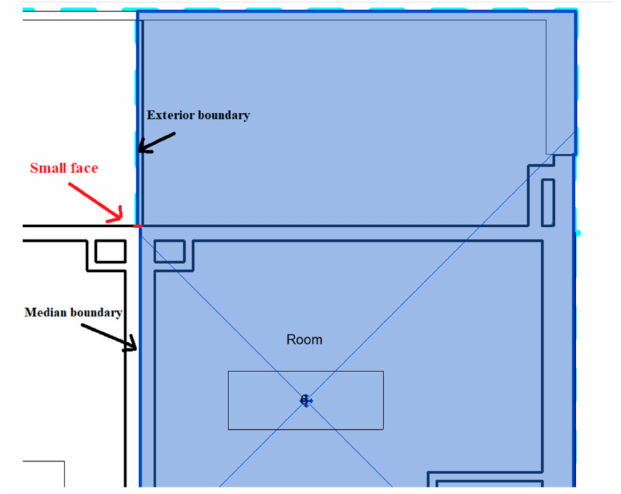
Figure 32. Connecting an Exterior boundary to a Median boundary with a small